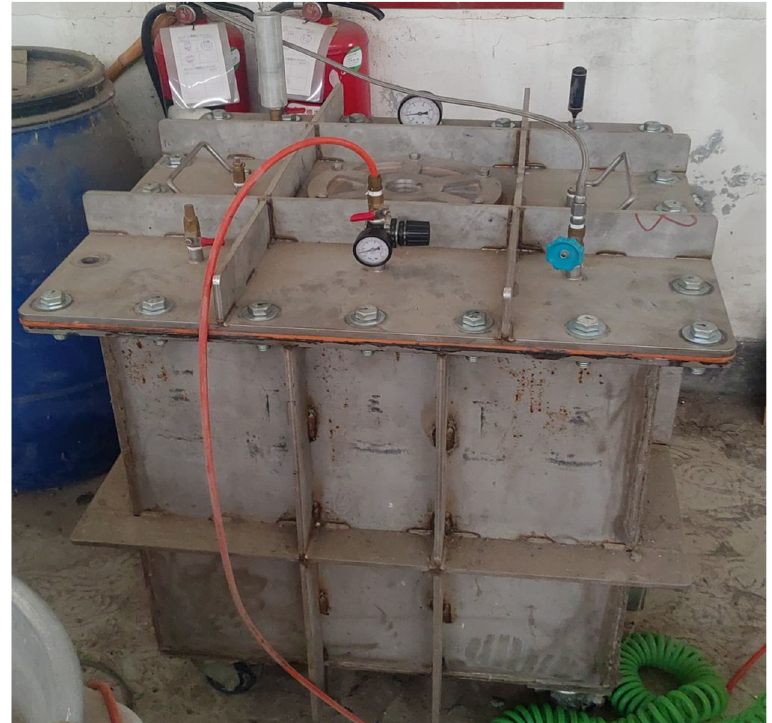
Figure 1. CO 2 pressure curing chamber. Table 3. Combination factors of concrete CO 2 curing test.